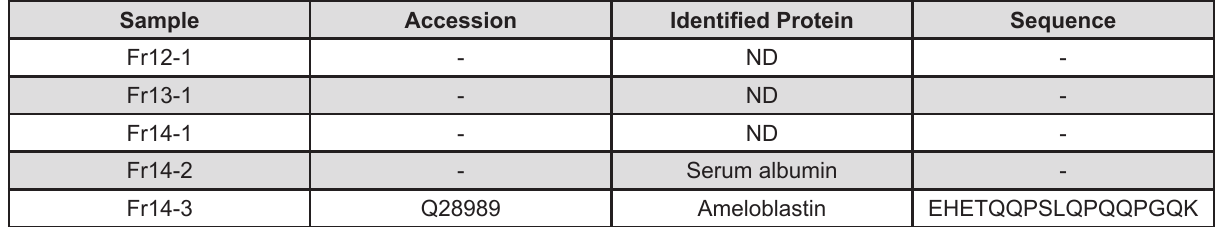
Figure 3- Identified peptides in protein spots among bioactive fractions of enamel matrix derivative (EMD) by